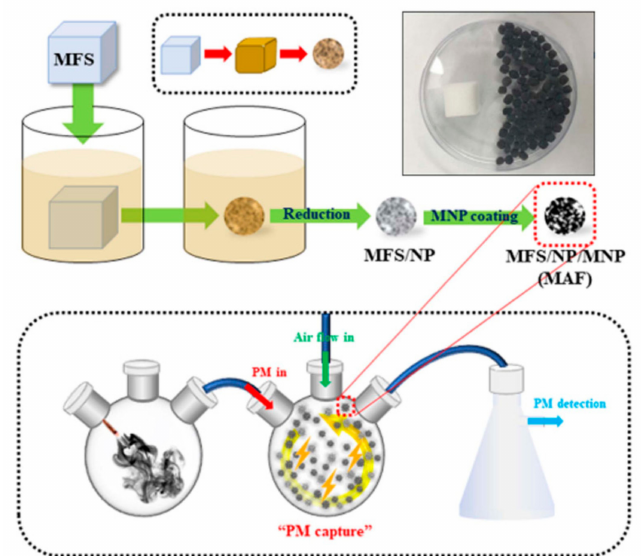
Figure 6. A schematic illustration of movable air filter (MAF) formation and a novel air filtration system in which MAFs are vigorously moved or rotated for the removal of PM particles. Inset: an melamine formaldehyde sponge (MFS) (1.12 × 1.12 × 1.12 cm 3 ) and 100 MAFs. Reproduced with permission from [82]. Copyright 2019 The Royal Society of